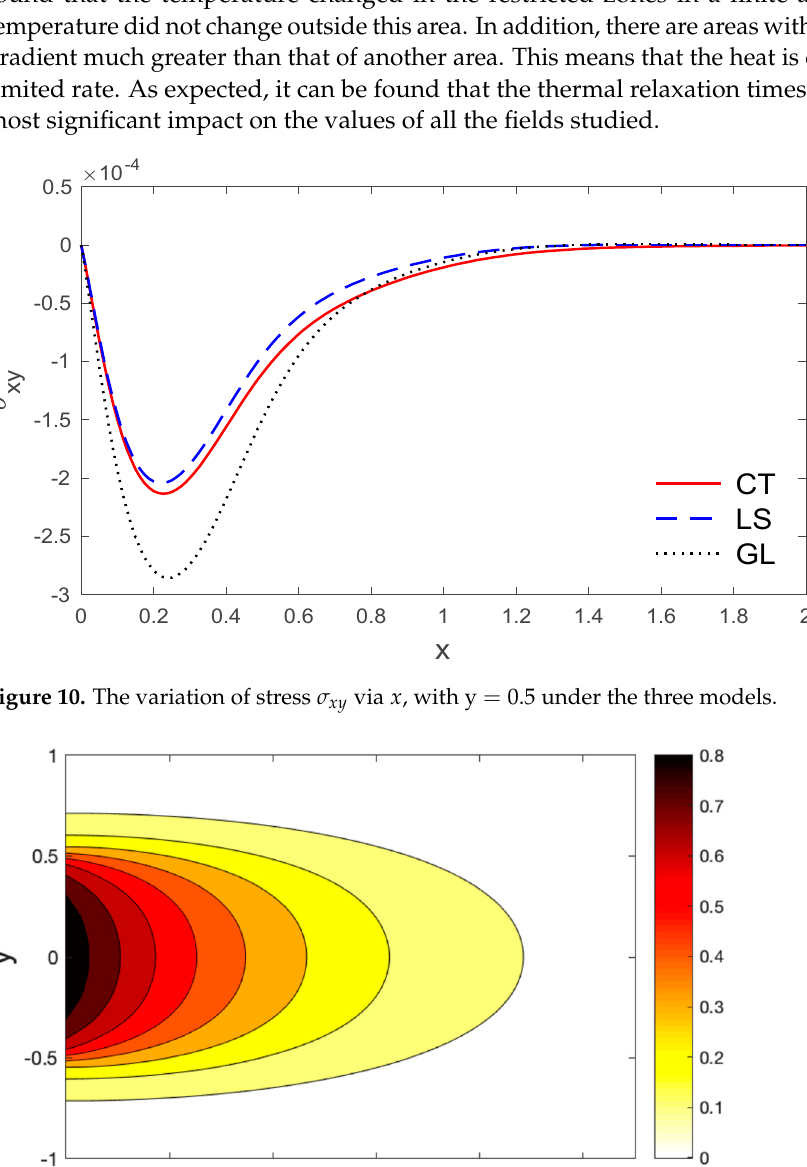
Figure 11. Contour plots of the temperature variations under the CT model.